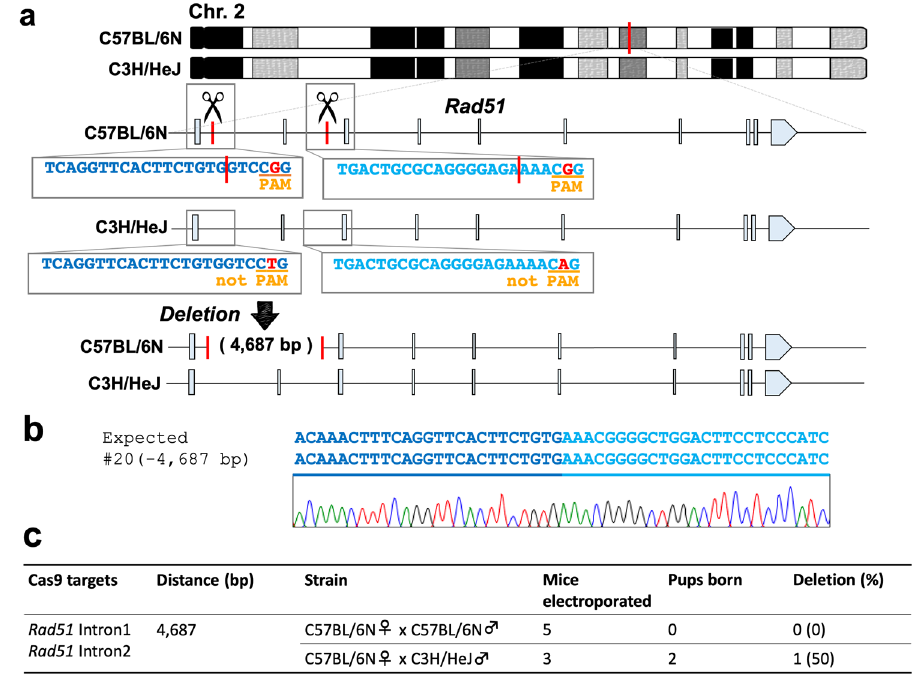
Figure 4. Lethal gene deletion in mouse zygotes via targeting the selected allele in F 1 hybrid mice using in vivo electroporation. ( a ) Schematic of Rad51 gene deletion in F 1 hybrid mice, which was generated in only the C57BL/6NCrSlc allele. ( b ) Alignment of sequences corresponding to the Rad51 intron 1 and intron 2 genomic breakpoint junctions. ( c ) Summary of the experimental efficiency of chromosomal deletion via in vivo